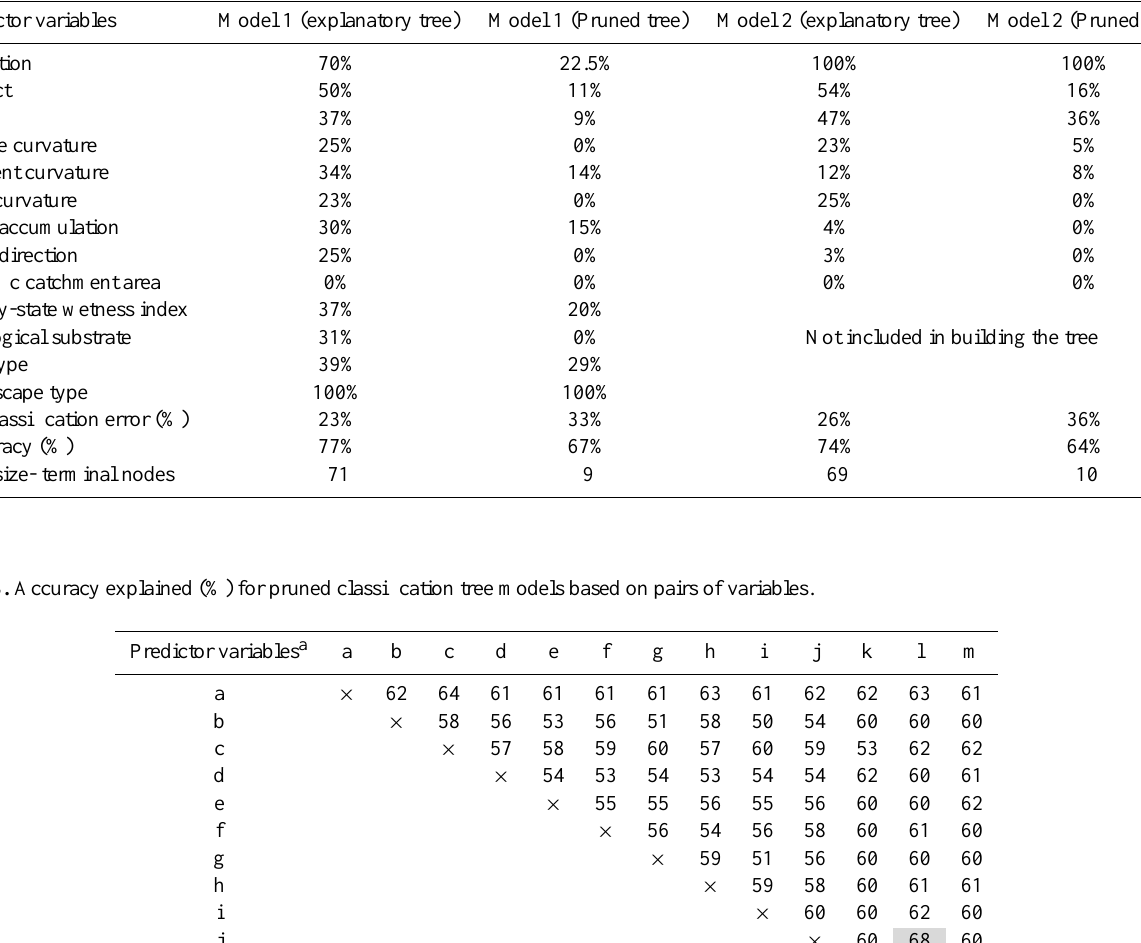
Table 2. Relative importance of predictor variables and misclassification error rates in Models 1 (based on all variables) and 2 (based on morphologic/hydrologic variables only).